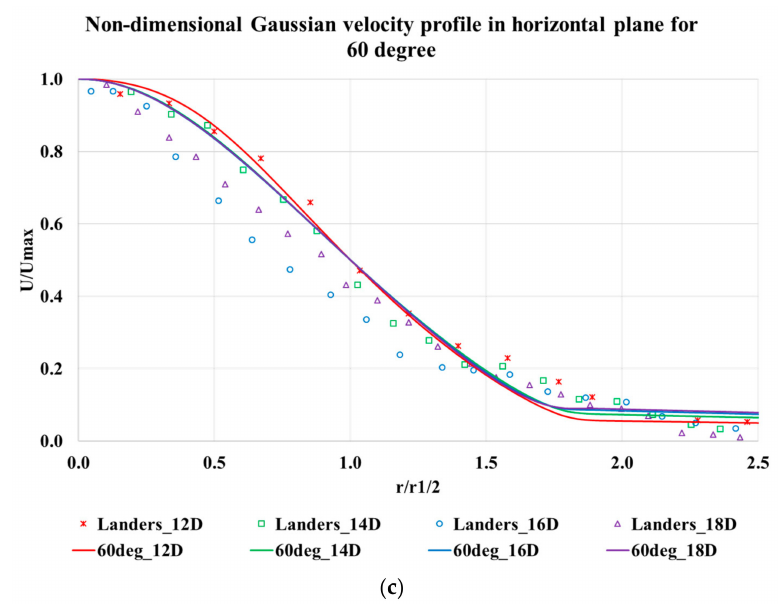
Figure 8. Non-dimensional velocity profile in horizontal plane for different impingement angle: ( a ) 30 degree; ( b ) 45 degree; and ( c ) 60 degree.